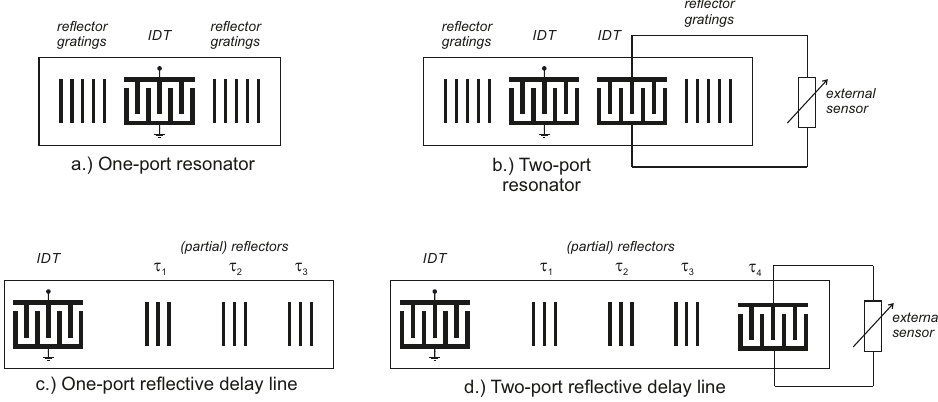
Figure 1. Schematic layout of passive surface acoustic wave (SAW) devices for sensor